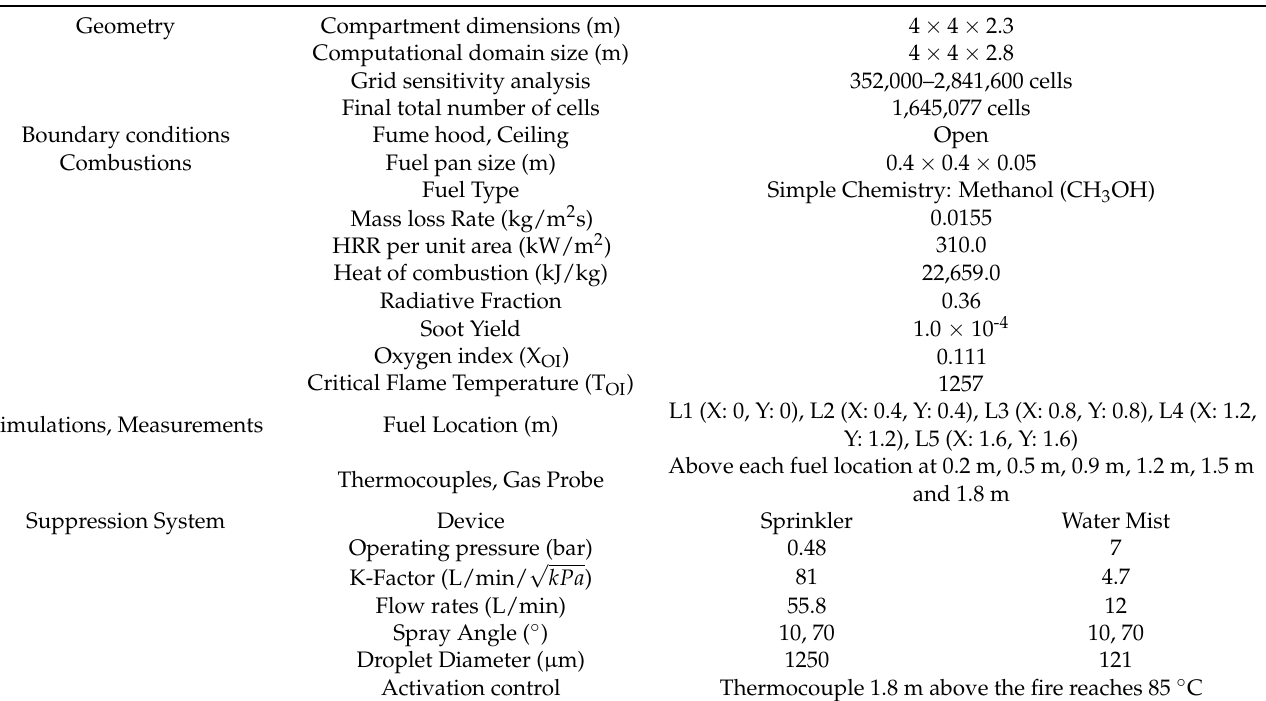
Table 1. Simulation setup.